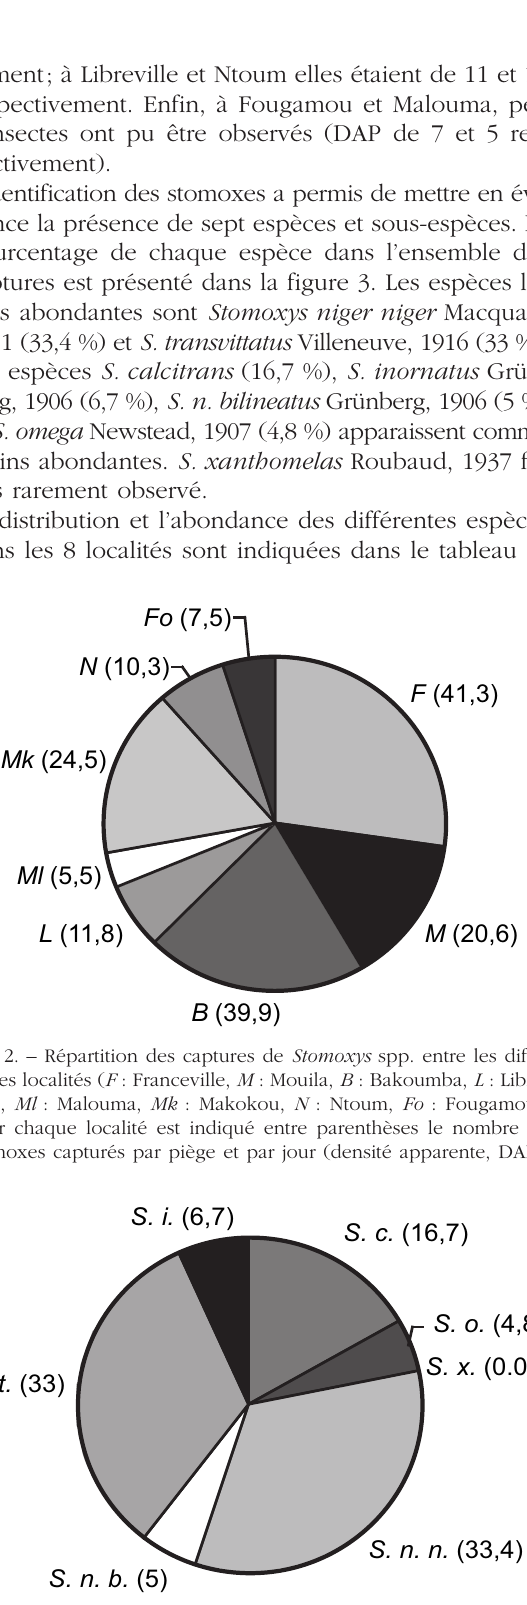
Fig. 3. – Répartition des captures des différentes espèces de Stomoxys ( S. t. : Stomoxys transvittatus , S. c. : S. calcitrans , S. n. n. : S. niger niger , S. n. b. : S. niger bilineatus , S. o. : S. omega , S. i . : S. inor- natus, S. x. : S. xanthomelas ), Pour chaque espèce, le pourcentage